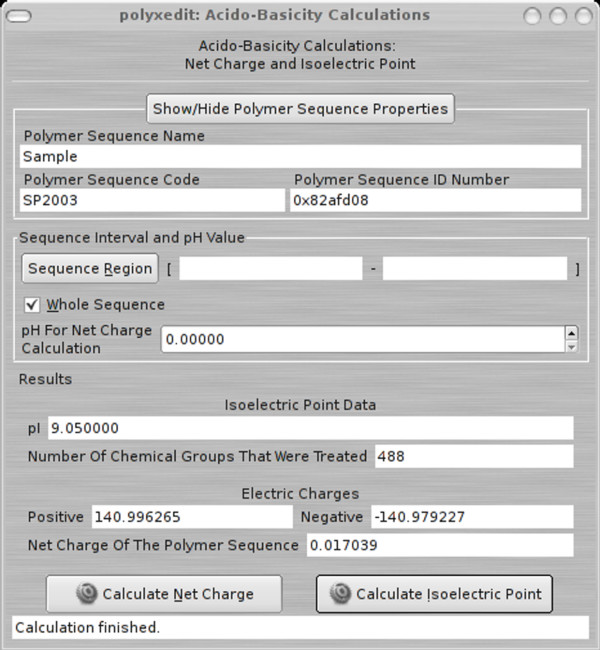
Isoelectric point and net charge calculations. This figure shows that two calculations are available: the calculation of the net charge of a polymer sequence when it is at a given pH value (left button) or the calculation of the isoelectric point of the polymer sequence (right button; our example). It is possible to make calculations on the whole polymer sequence or–by selecting a portion of the sequence in the editor–to restrict the calculation to that specific sequence region.